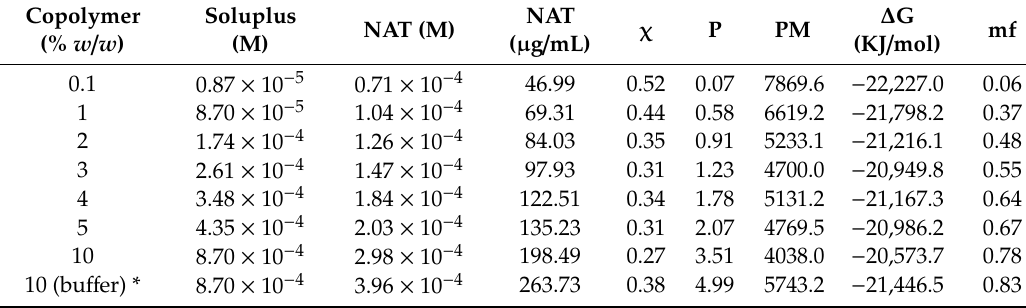
Table 2. Capability of Soluplus dispersions in 0.9% NaCl to solubilize natamycin, estimated using Equations (1)–(5). (NAT: natamycin; χ : molar solubilization capacity; P: partition coe ffi cient;